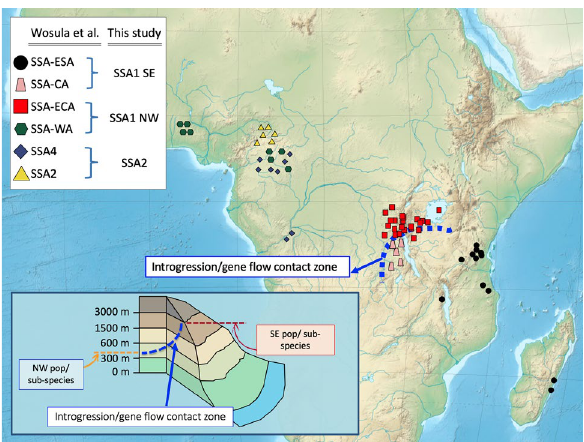
Figure 4. A map showing sampling sites of the SSA Bemisia cryptic species. The sample colour schemes and sampling sites followed Fig. 6B of Wosula et al. 38 (green: SSA-WA; red: SSA-ECA; pink: SSA-CA; black: SSA-ECA; Yellow: SSA2; blue: SSA4). Note: The SSA4 species is likely NUMT artefacts of the SSA2 species (refer to main text). The African topological map colour represents elevation from sea-level (see insert map of non-incremental approximation of elevation). The gene flow contact zone between populations on the NW–SE transect is indicated by the thick blue dashed line. Map modified and prepared using Microsoft PowerPoint for Mac, Version 16.39 (20071300). Sourced: https:// commo ns. wikim edia. org/ wiki/ File: Africa_ topog raphy_ map.